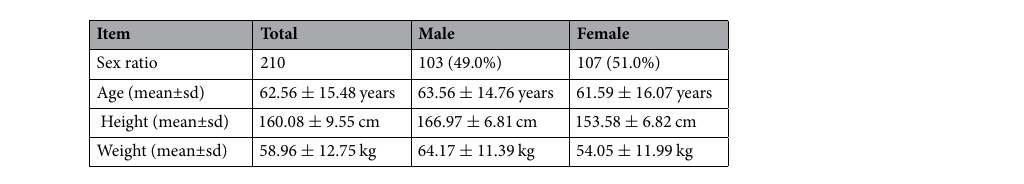
Table 5. Statistics of the selected 210 patients